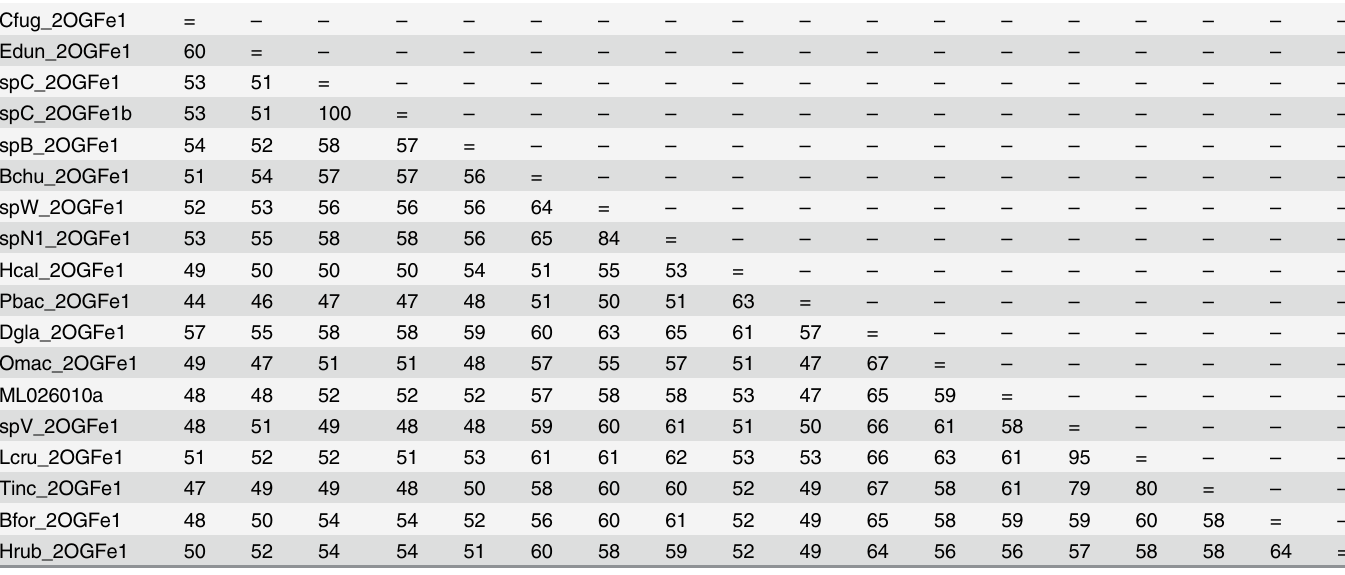
Table 6. Percent Identity Matrix of all 2-oxoglutarate Fe-Group 1 proteins.